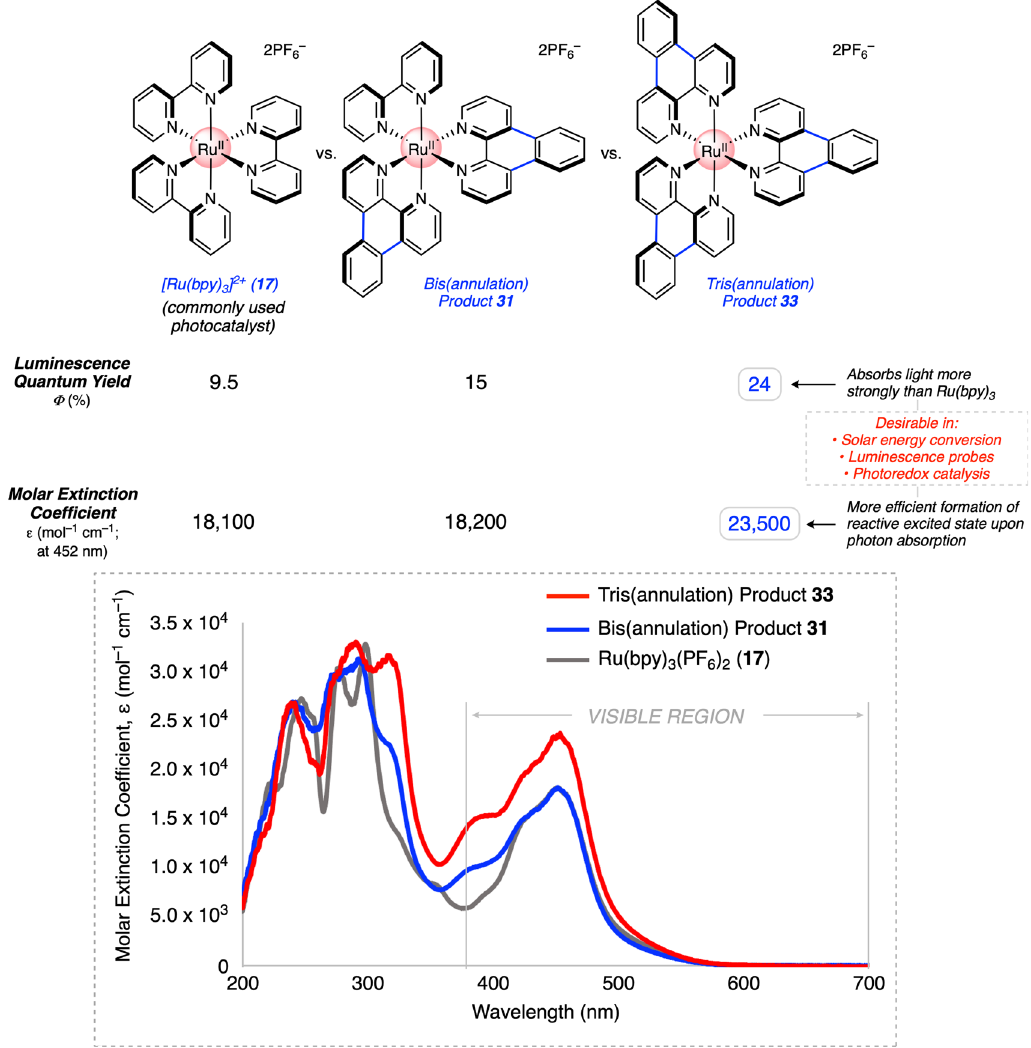
Fig. 9 Photophysical studies of bis(annulation) product 31 and tris(annulation) product 33 relative to [Ru(bpy) 3 ] 2 + (17). Evaluation of luminescence quantum yield ( Φ , %) and molar extinction coef fi cient ( ε , mol – 1 cm – 1 ). Experimental absorption spectra (molar extinction coef fi cient) are shown from 200 to 700